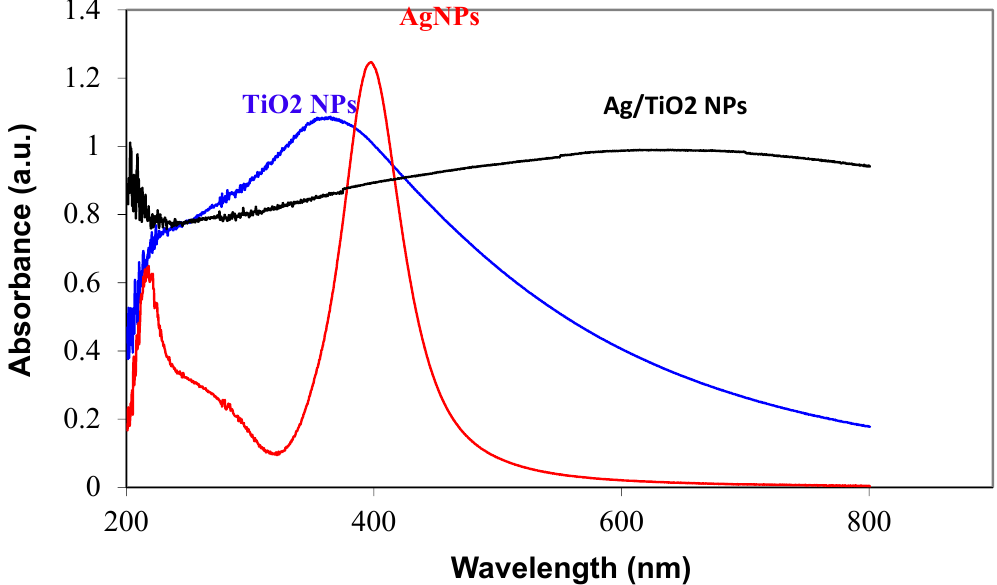
Figure 5. UV-Vis spectra of AgNPs, nano-TiO 2 , and AgNP-decorated nano-TiO 2 particles (dispersed in water).